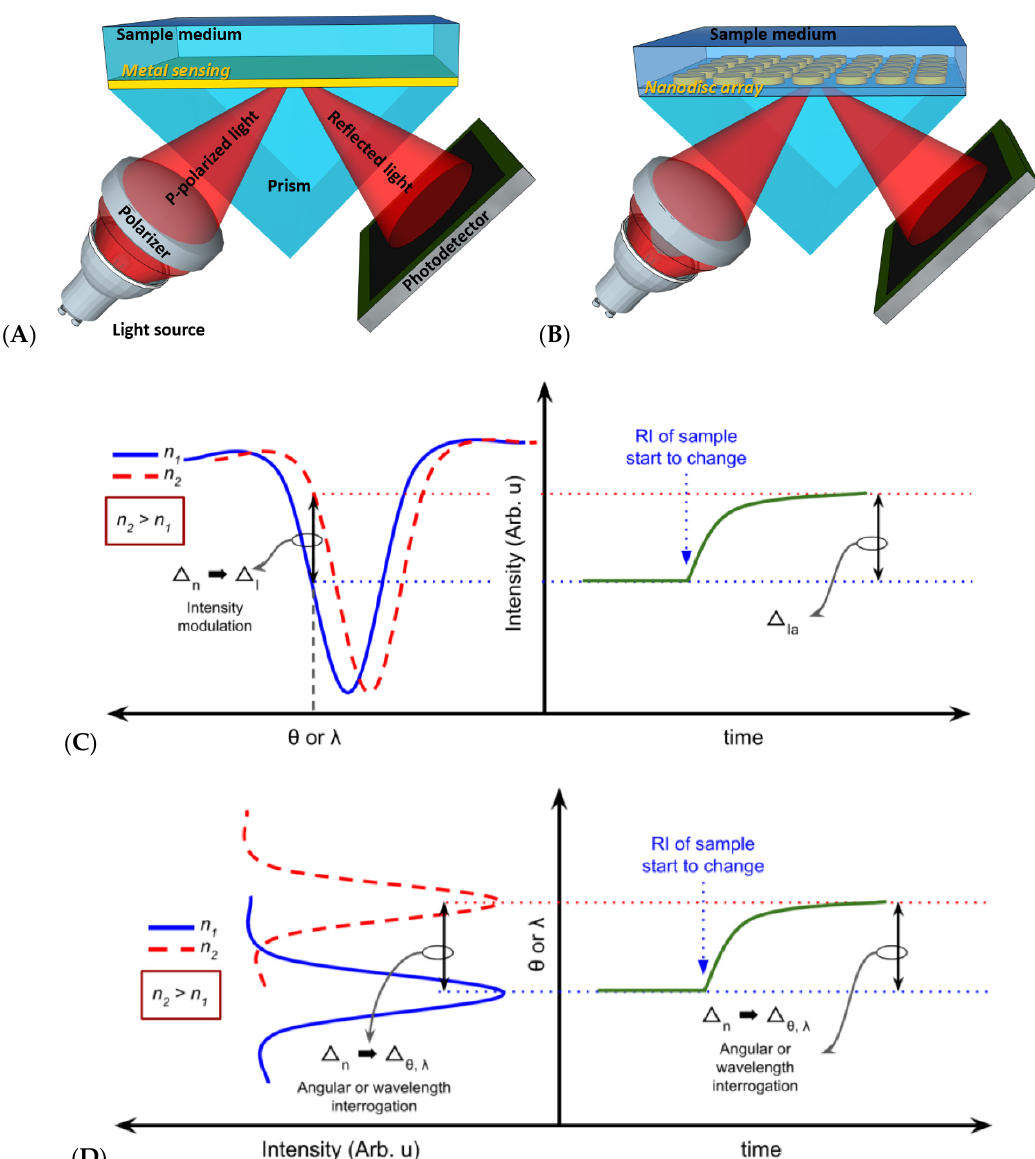
Figure 4. ( A ) SPR sensor configuration using a prism coupler and thin metal film for the sensing layer. ( B ) LSPR sensor using a nanodisc array. Signal acquisition of SPR sensor performed using ( C ) intensity modulation and ( D ) angular or wavelength interrogation. ( C , D ) are reprinted from [29] under the Creative Commons Attribution (CC BY) license.